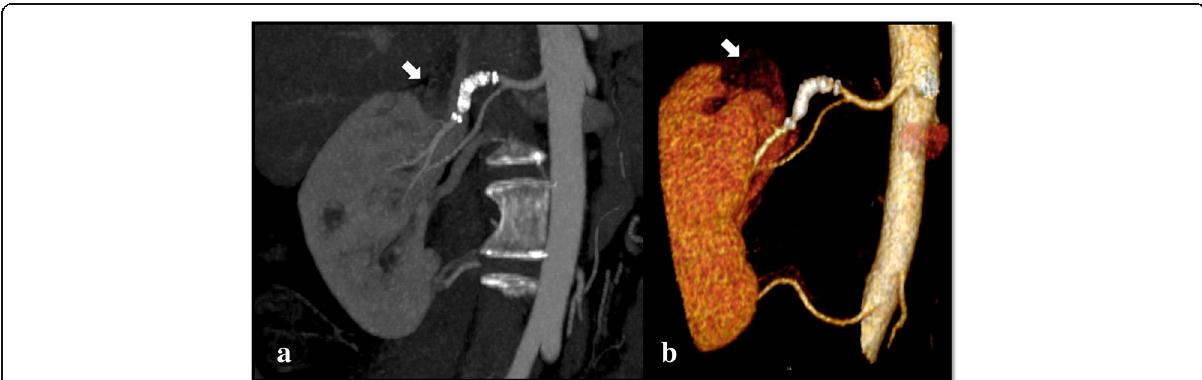
Fig. 4 a , b Coronal CTA ( a ) and 3D volume rendered (VR) imaging ( b ) at 12 months demonstrating developing of complete exclusion of the aneurysm and the patency of the stent. A small area of hypoperfusion in the upper pole of the kidney is visible (large arrow)